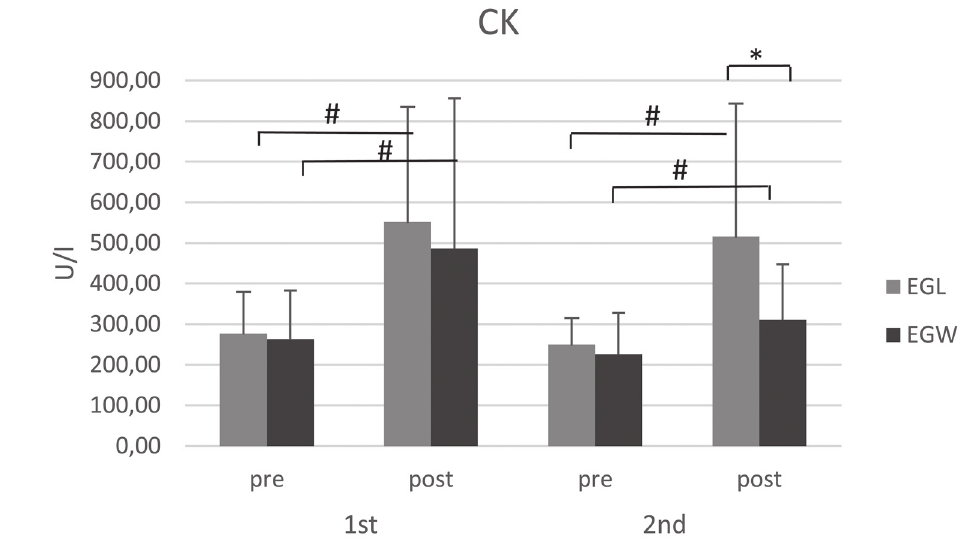
FIGURE 1 Creatine kinase results before (pre) and after (post) the first (1st) and last (2nd) plyometric training sessions Note: * indicates a significant difference (p<0.05) between the results of the two experimental groups; indicates a sig- nificant difference (p<0.05) between the results before (pre) and after (post) the plyometric training